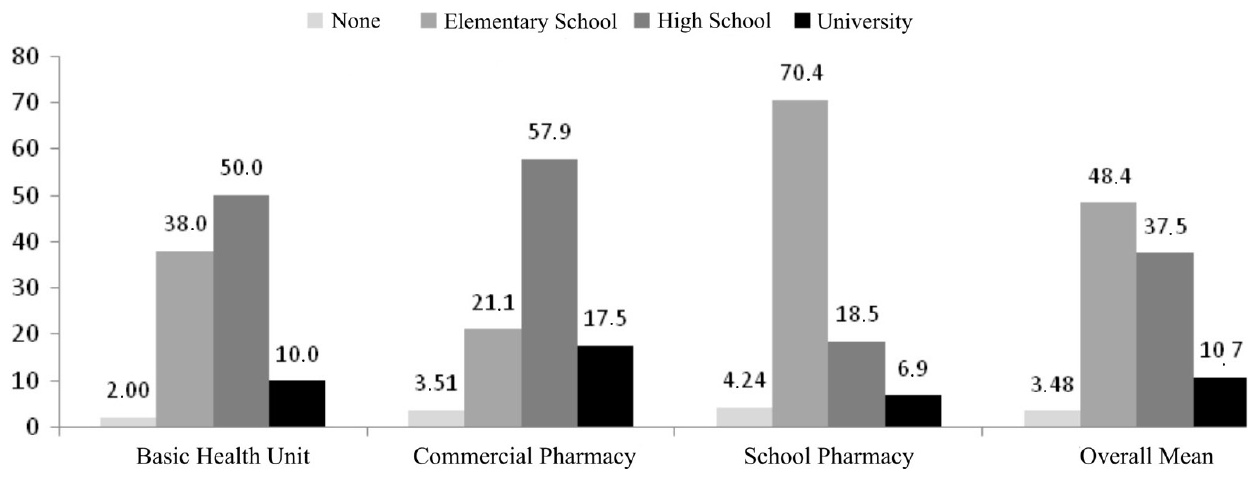
FIGURE 1 – Educational level of antibiotic users – Sorocaba, São Paulo State.